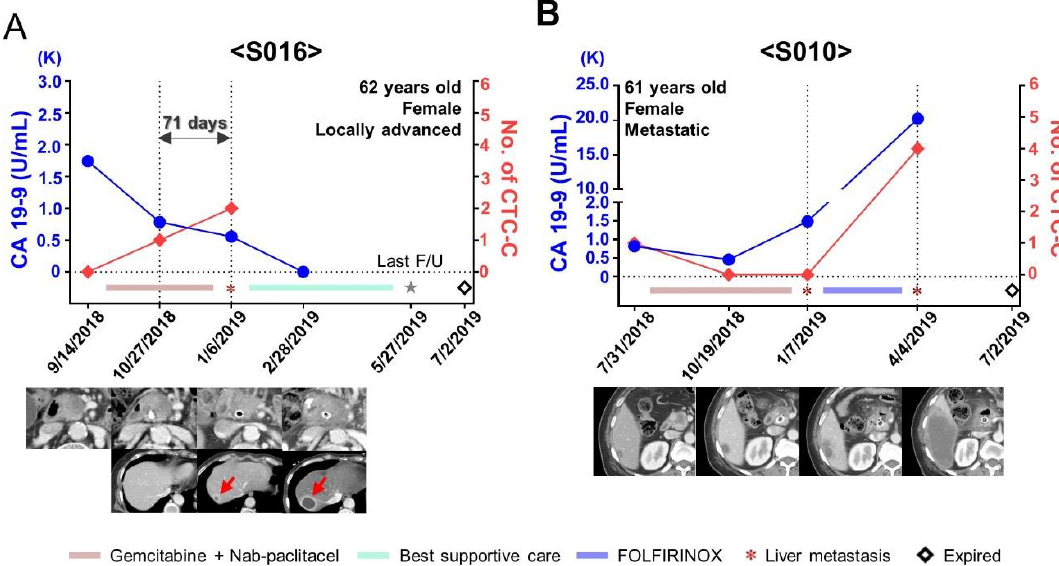
Figure 6. Longitudinal follow-up of unresectable pancreatic cancer patients. ( A ) Changes in the level of carbohydrate antigen 19-9 (CA 19-9) and the number of CTC-C (circulating tumor cell (CTC) clusters) in patient S016 during the follow-up. An increase in the number of CTC-C was found 71 days before the evidence of progression with computed tomography. ( B ) Changes in the level of CA 19-9 and the number of CTC-C in patient S010 during the follow-up. S010 had the presence of CTC-C accompanying liver metastasis at baseline treatment-naïve status. CTC-C were not detected after starting chemotherapy; however, the number of CTC-C surged when the liver mass suddenly increased.